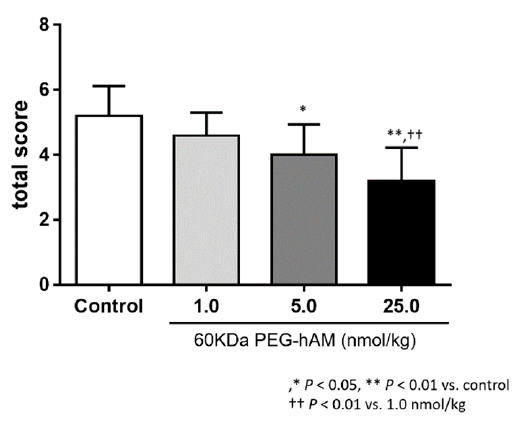
Figure 7. Anti-Inflammatory Effects of 60 kDa PEG-hAM on DSS-Induced Colitis. A comparison of the total inflammation score in the DSS-induced colitis model after treatment with 60 kDa PEG-hAM ( n = 10). In mice with DSS-induced colitis, treatment with 60 kDa PEG-hAM reduced bloody stool and body weight reduction scores. The total inflammation scores were lower in the group treated with 60 kDa PEG-hAM than in controls. Results are shown as the mean ± SE. * p < 0.05, ** p < 0.01 versus control and †† p < 0.01 versus 1.0 nmol/kg 60 kDa PEG-hAM (modified and drawn from